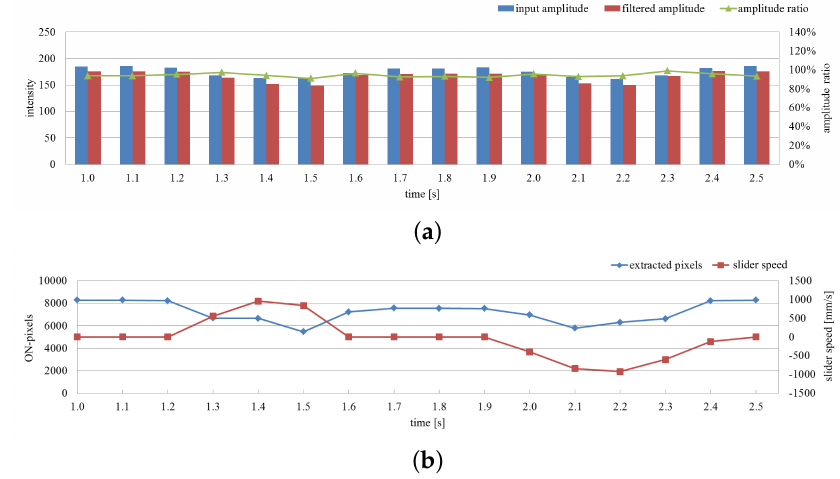
Figure 16. Averaged amplitude values and number of extracted pixels when a rotating fan moves. ( a ) Averaged amplitudes of input and pixel-wise filtered images and their ratios on the extracted pixels; ( b ) number of extracted pixels as vibration region and slider